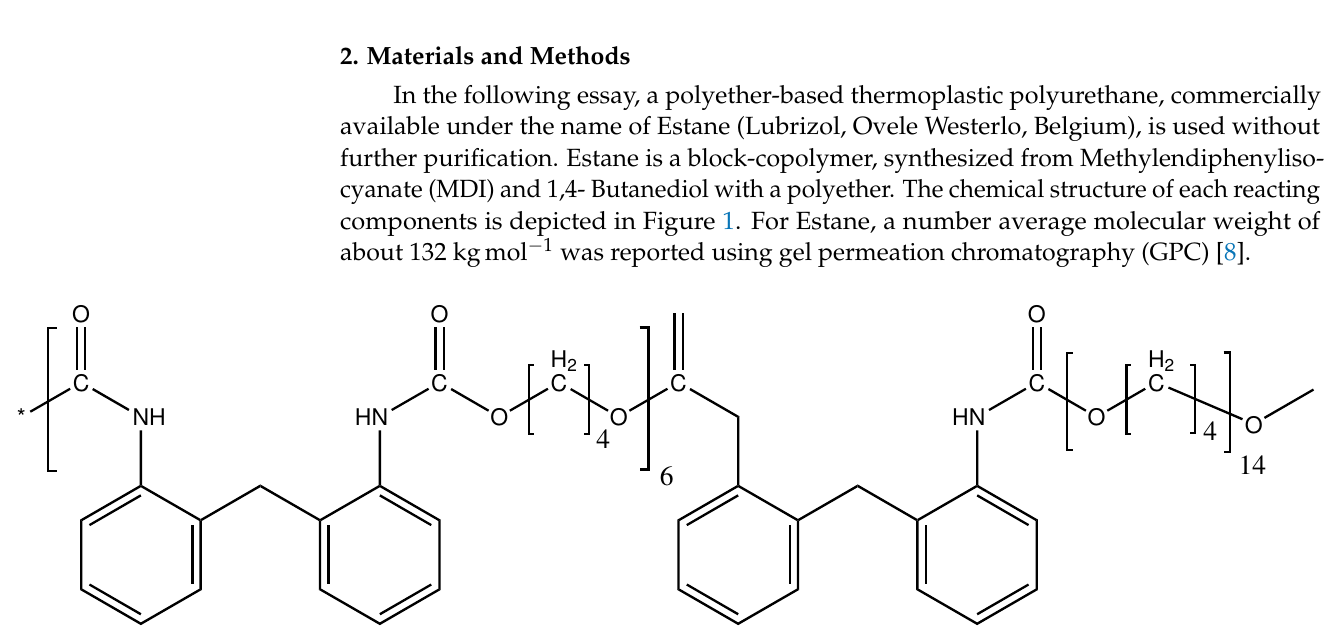
Figure 1. The chemical structure of Shape-Memory polyetherurethane